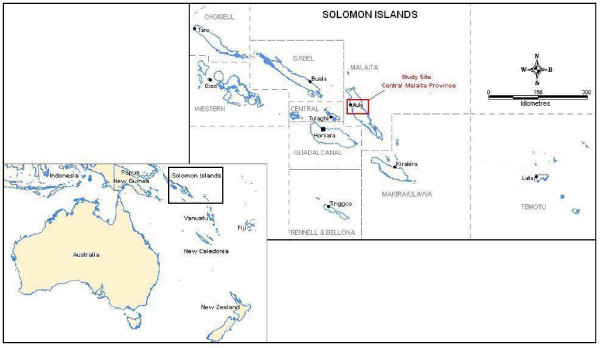
Map of region showing study area.